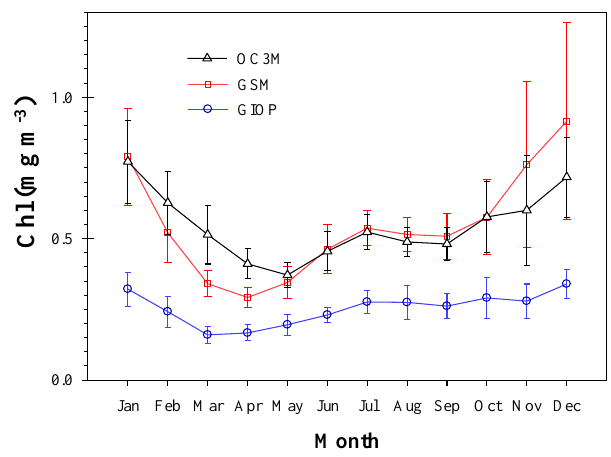
Fig. 4. Monthly climatology of MODIS Chl for the northern South China Sea 26 (16-25 º N, 105-121 º E, the region of Fig. 3). 27